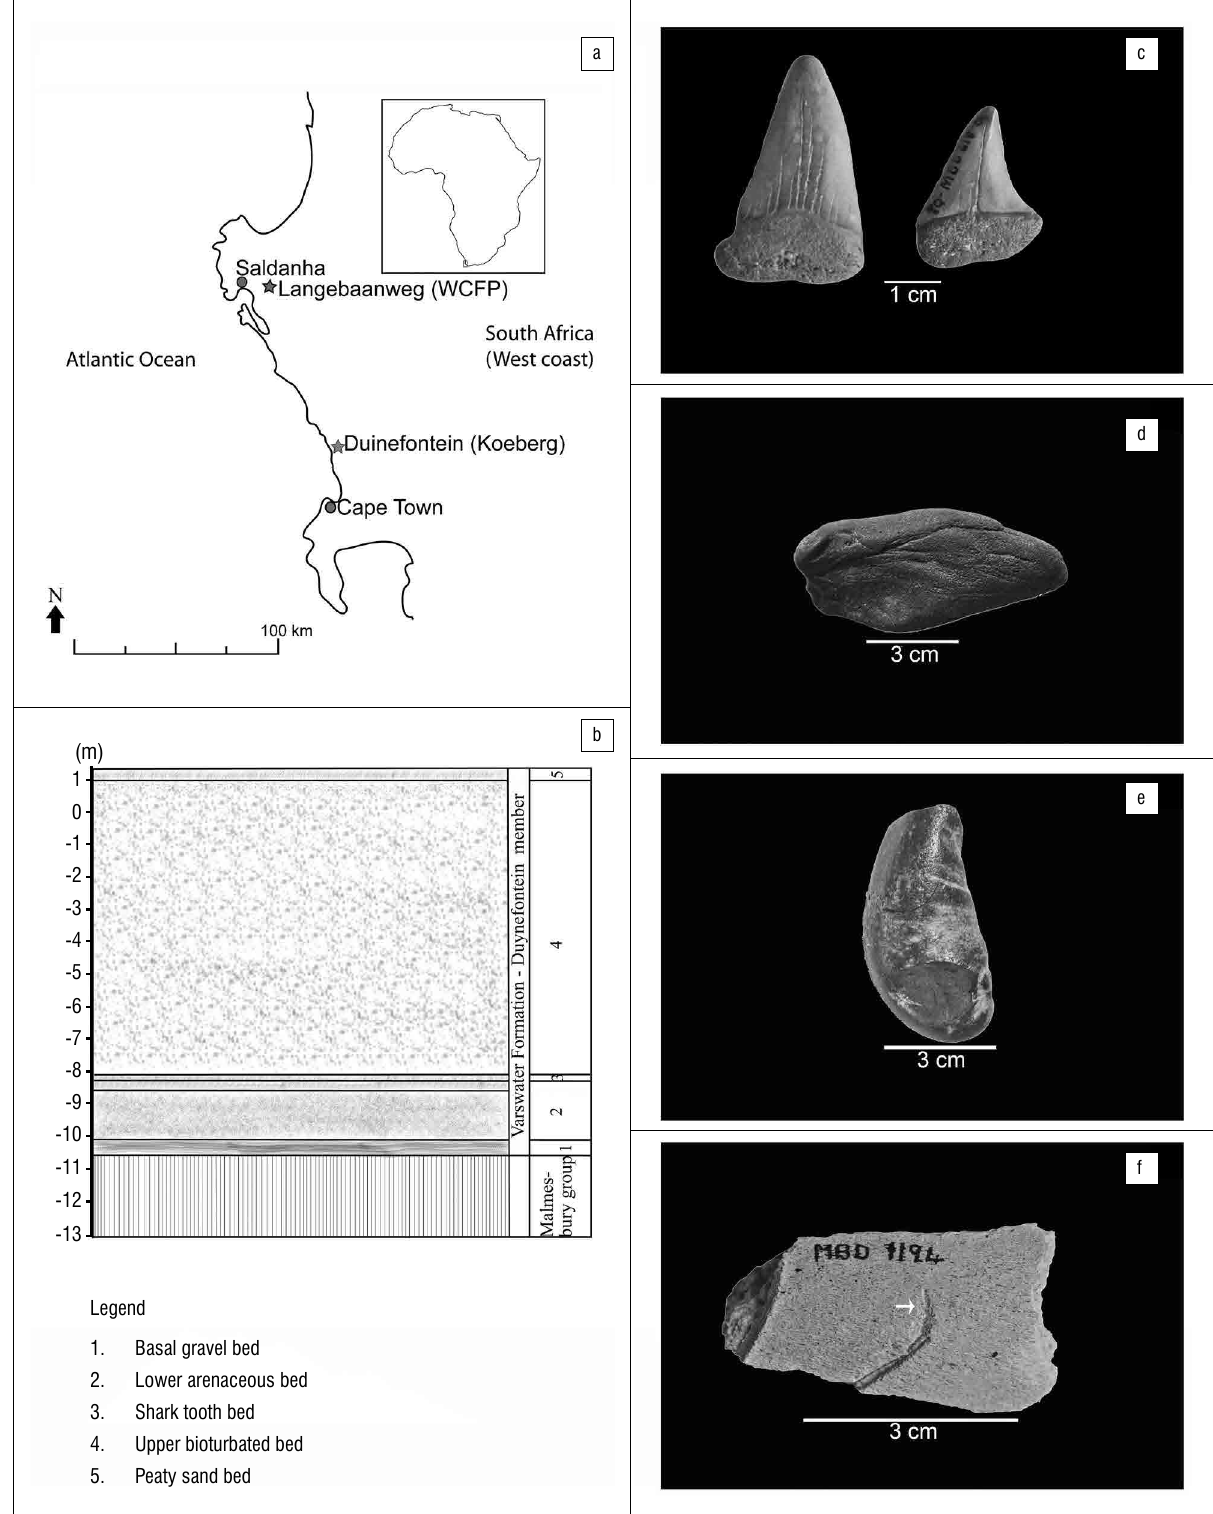
Figure 1: (a) Location of Duinefontein (Koeberg). (b) Schematic showing the stratigraphy for Koeberg – Duynefontein Member, Varswater Formation (based on Rogers 3 ). (c) Shark teeth (SAMPQMB-D-618G, SAMPQMB-D-618Q) showing evidence of abrasion. (d) Rolled periotic posterior process (SAMPQMB-D-65). (e) Tympanic bulla showing a polished surface (SAMPQMB-D-1197). (f) CF1a bite mark on cranial fragment (arrow)